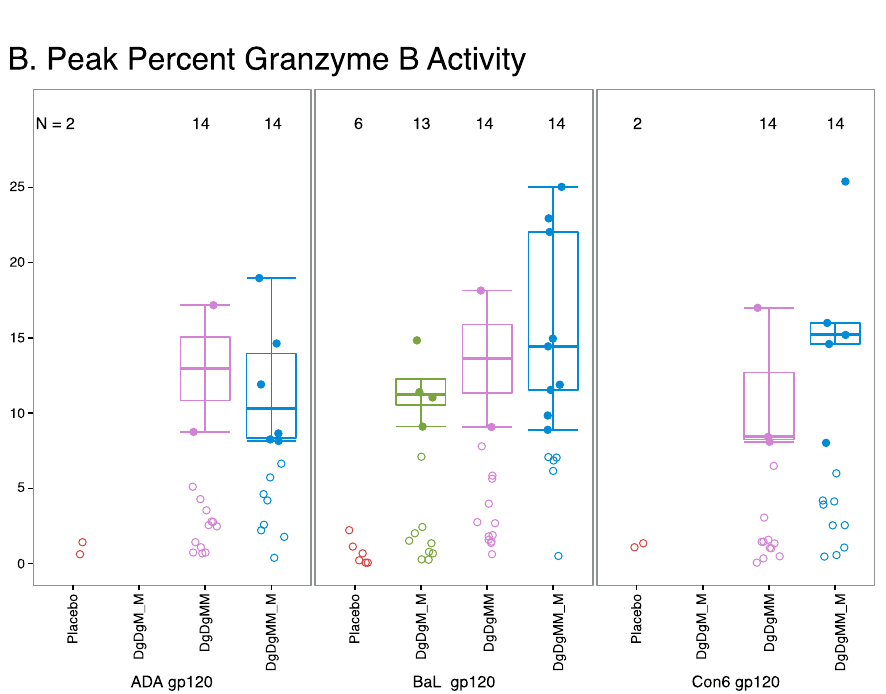
Fig 6. A. ADCC response rate (GTL). B. ADCC response magnitude. (A) Peak ADCC responserates. (B) Peak ADCC responsemagnitudes. Responses are to individual antigens at two weeks after the 2nd and 3rd MVA or placeboin the Placebo, DgDgM_Mand DgDgMM_Mgroups. DgDgM_Mrefers to immune